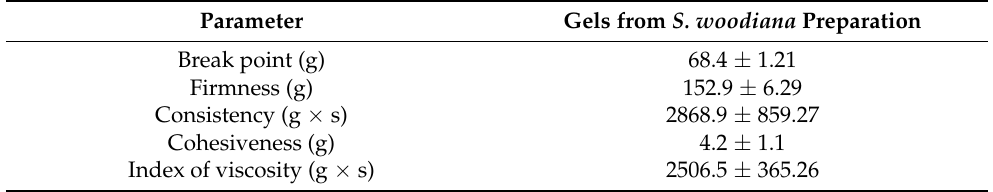
Table 7. Main textural parameters of gel formed from S. woodiana powder diluted in water (10% w / v